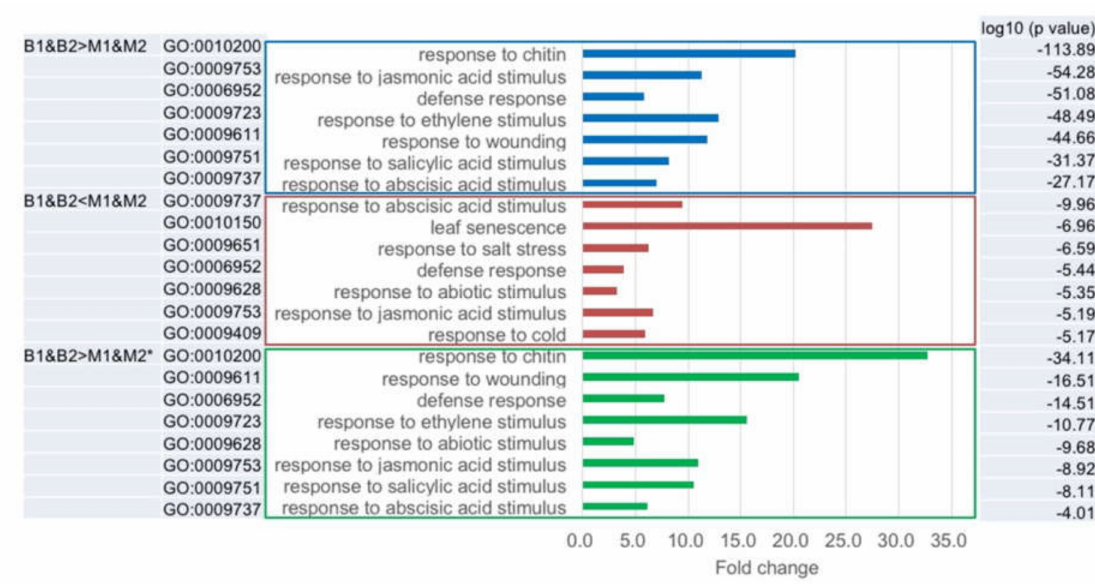
Figure 5. Gene ontology (GO) classification in B1&B2 > M1&M2 and B1&B2 < M1&M2 expressed genes. * represents overrepresented GO categories in B1&B2 > M1&M2 expressed genes and di ff erentially expressed genes in C24 / Col and C24 / L er hybrids compared with MPV.